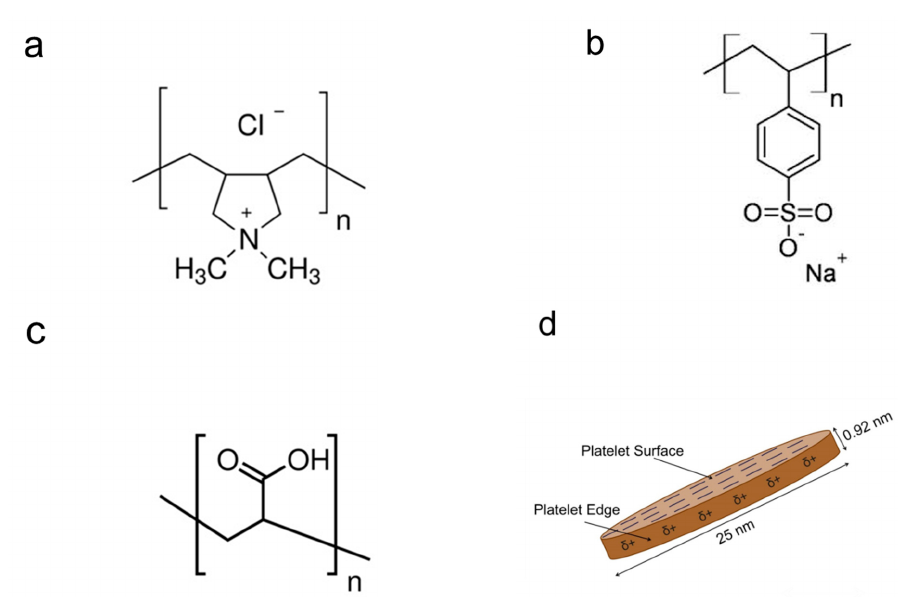
Figure A1. Chemical structure of ( a ) PDDA, ( b ) PSS, and ( c ) PAA. ( d ) Schematic of a laponite platelet.